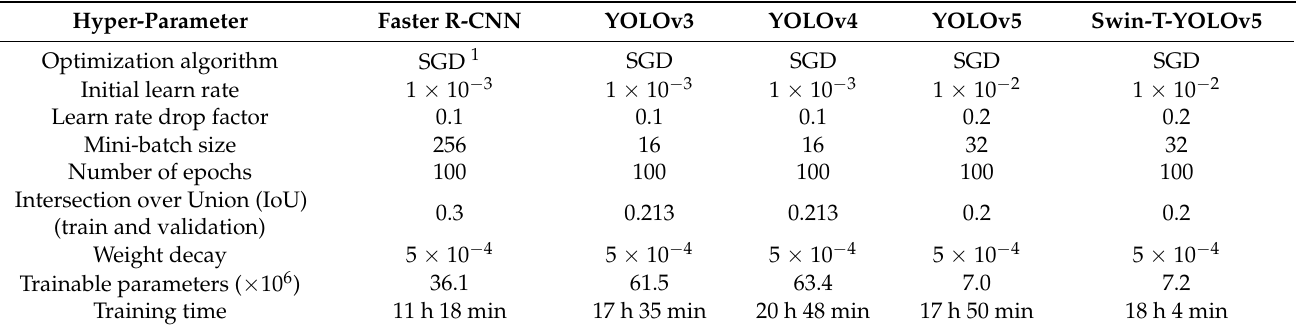
Table 3. Major hyper-parameters used in this study for YOLOv3, YOLOv4, YOLOv5, and Swin- transformer-YOLOv5